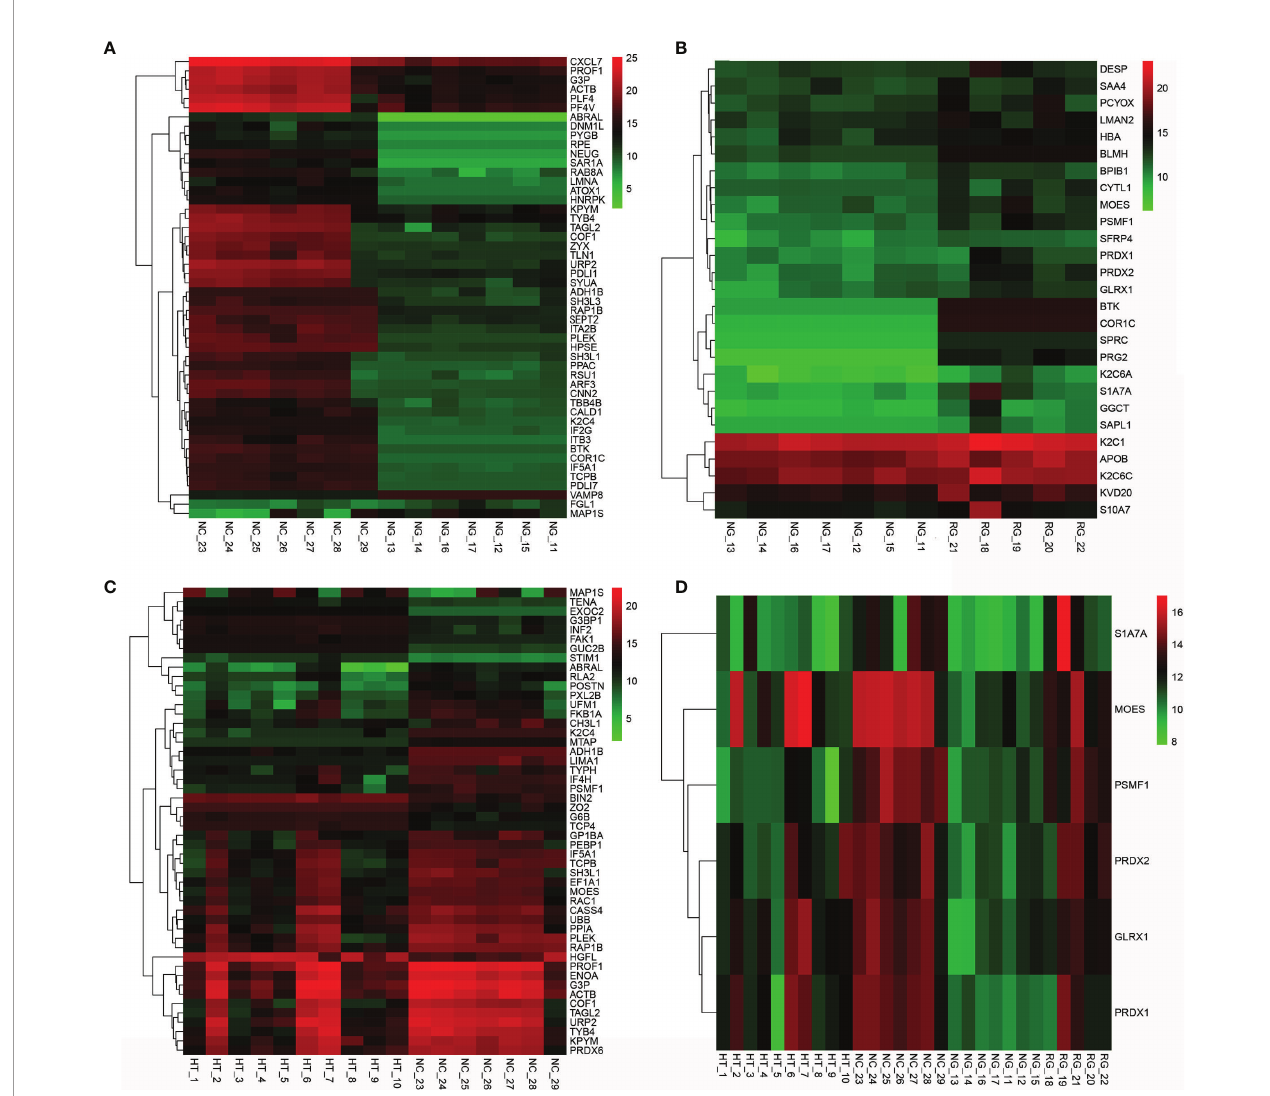
FIGURE 1 | Clustering heat map of differential proteins between AITD and NC groups (A) , NG group vs. NC group (B) , NG group vs. RG group (C) , and HT group vs. NC group (D) . NG group vs. RG group vs. HT group vs. NC group. AITD, autoimmune thyroid disease; NC, normal control; NG, newly diagnosed Grave ’ s disease; RG, refractory Grave ’ s disease; HT, Hashimoto ’ s